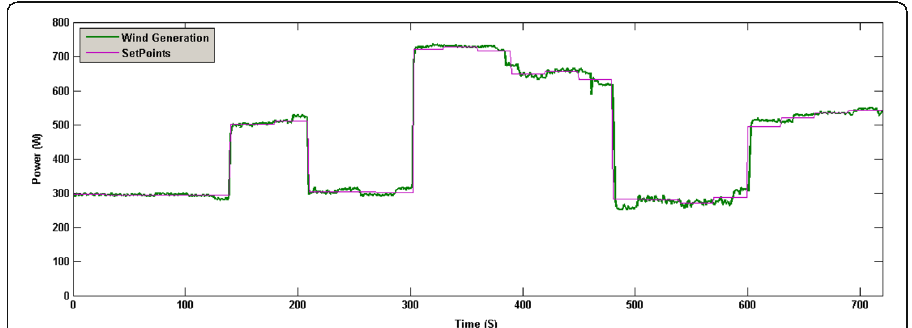
Fig. 9 Real-time results of wind turbine emulator in BUS